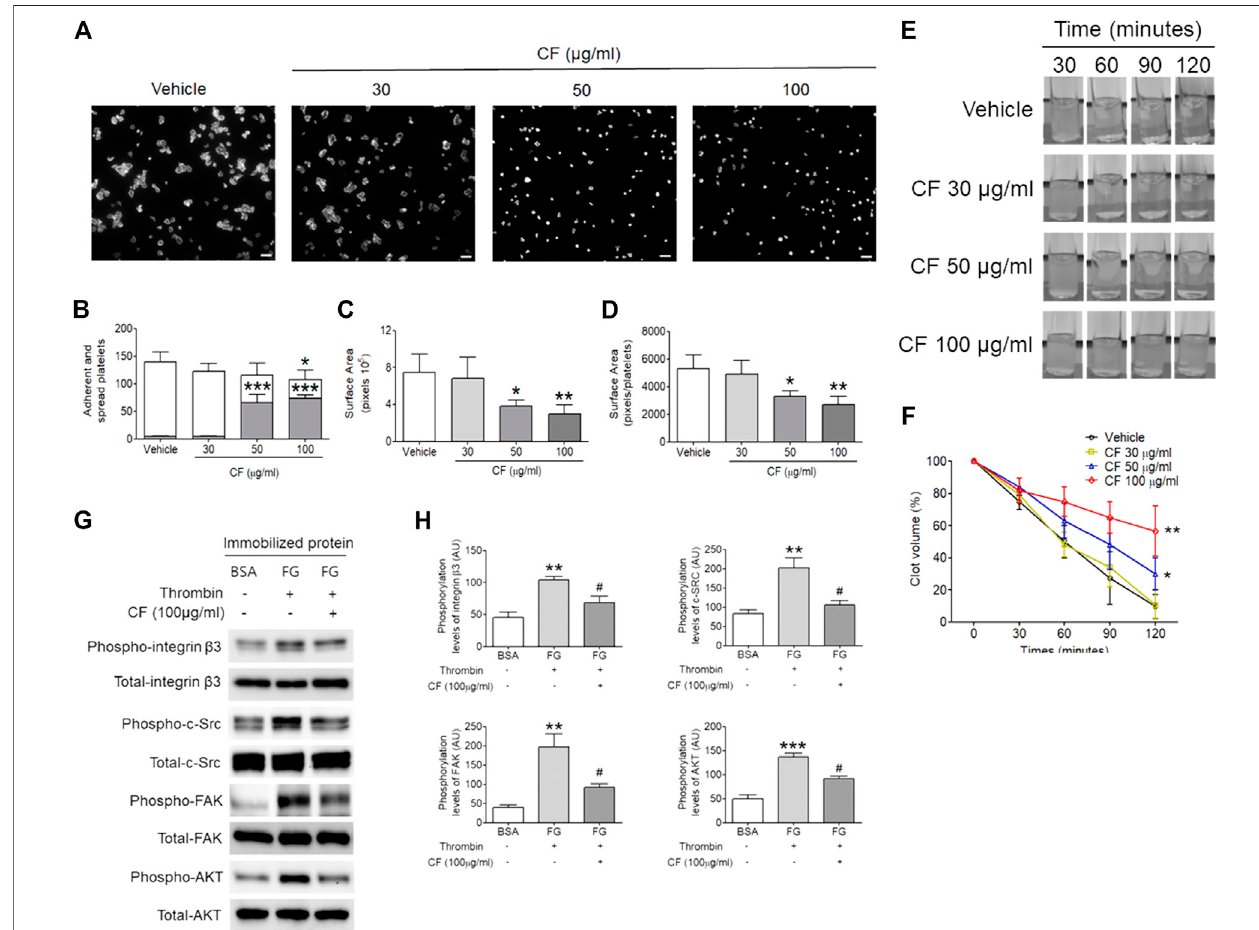
FIGURE 3 | C. fragile shows a defective α IIb β 3 integrin-dependent spreading on fi brinogen and fi brin clot retraction. Washed platelets pre-treated with various concentrations of C. fragile (30, 50, and 100 μ g/ml) or vehicle control (0.01% DMSO) and incubated on FG-coated surfaces for 2 h at 37 ° C. Adherent and spread plateletswerestainedwithrhodamine-conjugated phalloidin. (A) Representativeimages.Scalebars:10 µm(white). (B) Numberofadherents (butnotspread,graybars) and fully spread (white bars). Platelet spreading was analyzed by the surface area (C) which was measured by the number of pixels divided by the number of platelets (D) inthe fi eld. (E,F) Mouseplateletswereincubatedwithvariousconcentrationsof C.fragile (30,50,and100 μ g/ml)orvehiclecontrol(0.01%DMSO)and fi brin clot retraction was assessed up to 2 h after addition of thrombin, fi brinogen, and CaCl 2 . (E) Representative photographs and (F) summary data were presented.